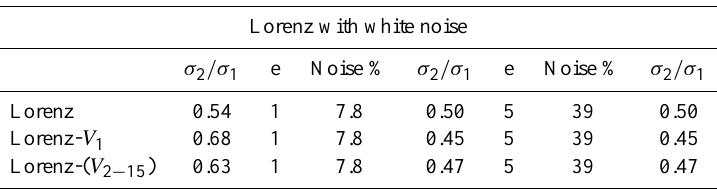
Table 2. This Table presents the ratio σ 2 /σ 1 estimated for the original Lorenz system, the stochastic (white noise) Lorenz system and the SVD components of the stochastic Lorenz system Lorenz with white noise σ 2 /σ 1 Noise